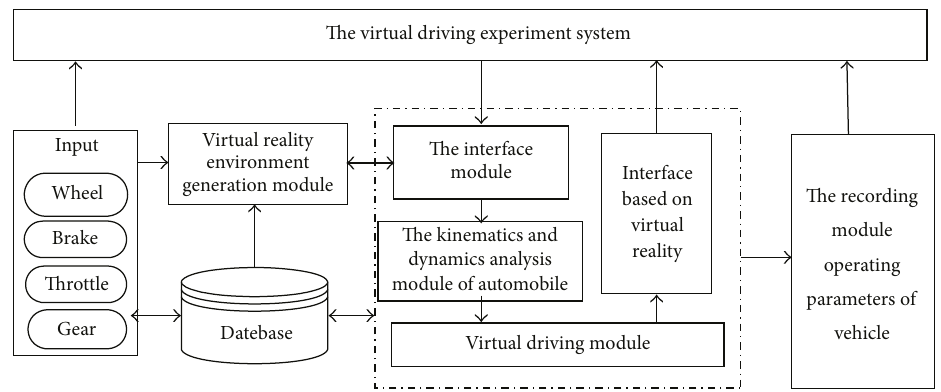
Figure 2: The structure of the driving